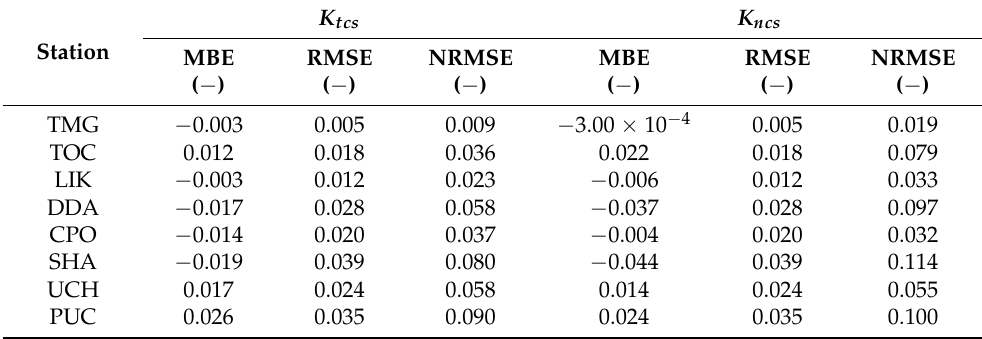
Figure 8. Detail on estimation error time series for GHI and DNI during eclipse conditions. Vertical dashed lines mark the beginning of the eclipse according to astronomical algorithm. Table 3. Estimation errors for clearness indexes under no eclipse conditions for the measurement stations.